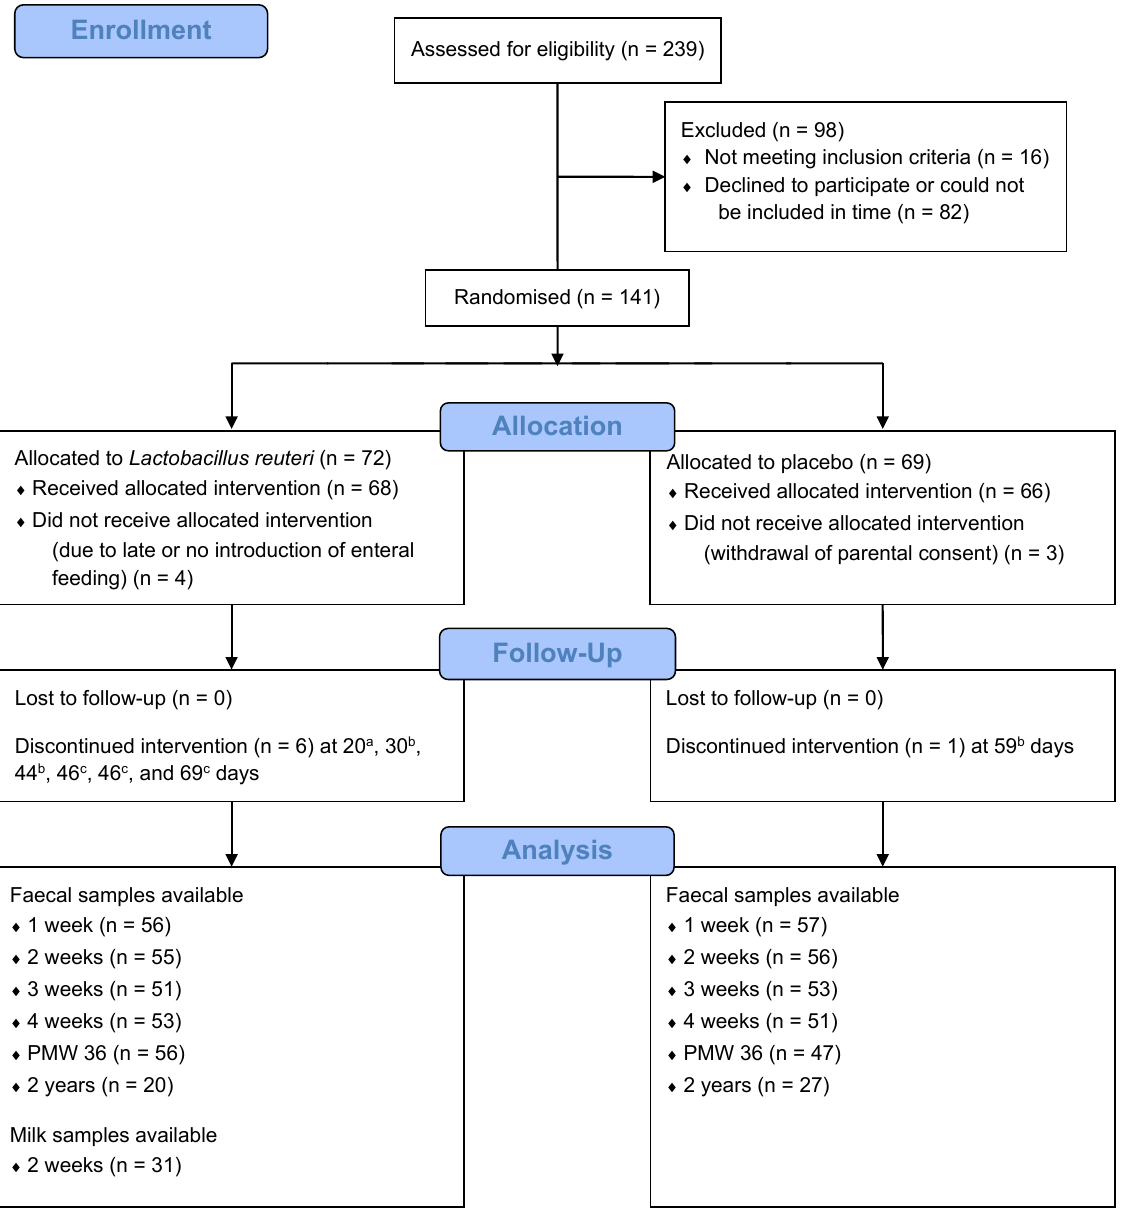
Figure 1. Flow chart of the PROPEL trial. PMW 36 = postmenstrual week 36. a Study product was discontinued by mistake after transfer to another hospital ( n = 1). b Study product was not administered by mistake after temporarily being withheld during nil oral ( n = 3). c Study product ran out temporarily at the study site ( n =